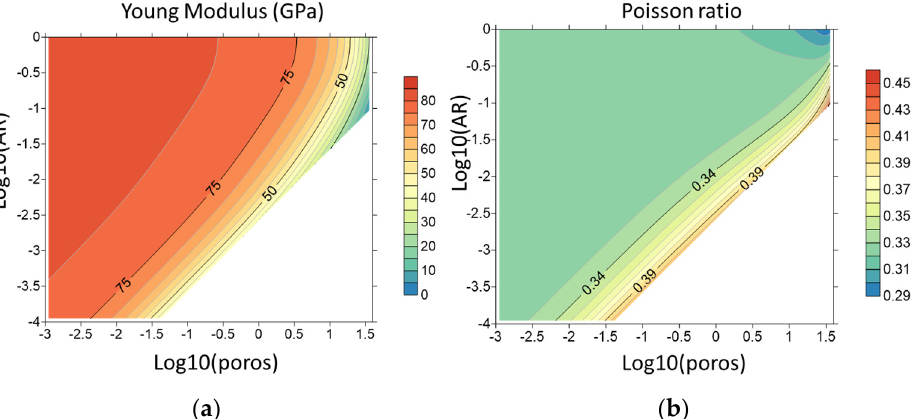
Figure 6. ( a ) Young’s modulus and ( b ) Poisson ratio for a model of carbonate matrix with randomly oriented brine-saturated voids versus decimal logarithms of porosity and void’s aspect ratio.